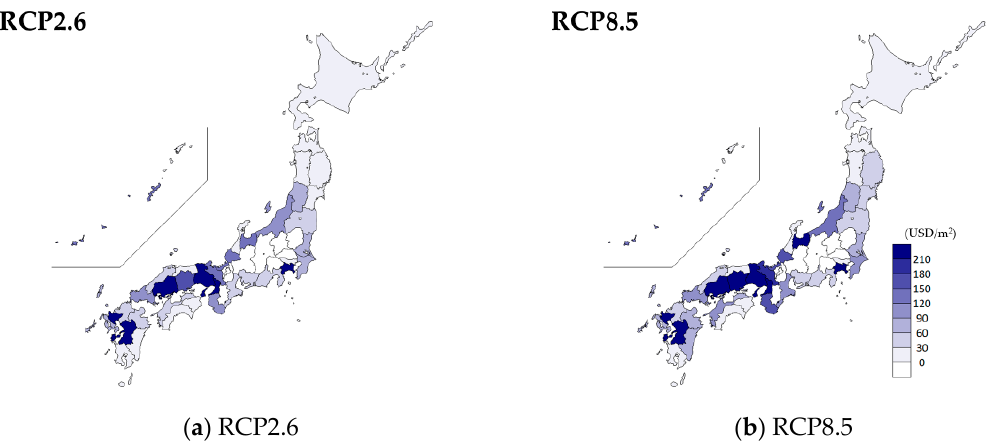
Figure 6. Prefectural damage costs per unit area for RCP2.6 ( a ) and RCP8.5 (b ) in 2081–2100. Table 6. Prefectural damage costs per unit area in four RCPs in 2081–2100.